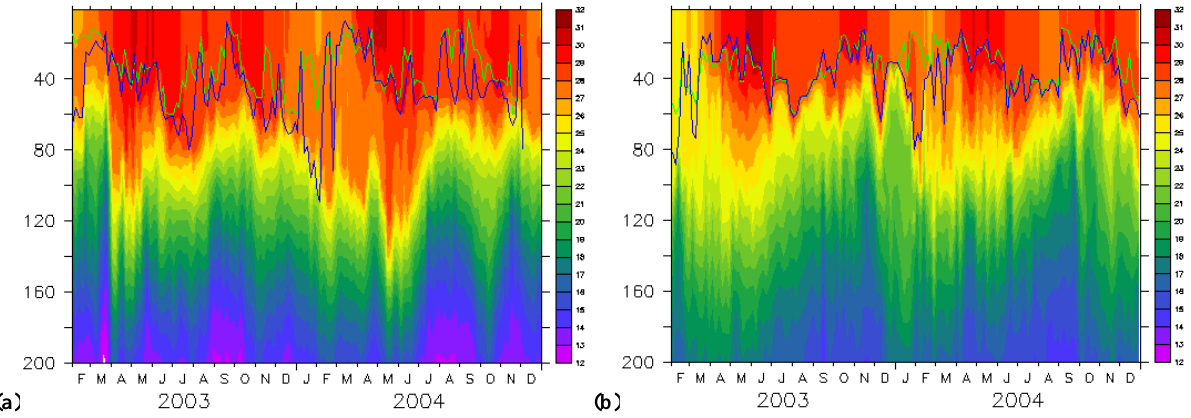
Fig. 4. Time depth series of temperature (a) BoB-2900093 (b) AS-2900090 with depth of the mixed layer (green) and depth of isothermal layer (blue)